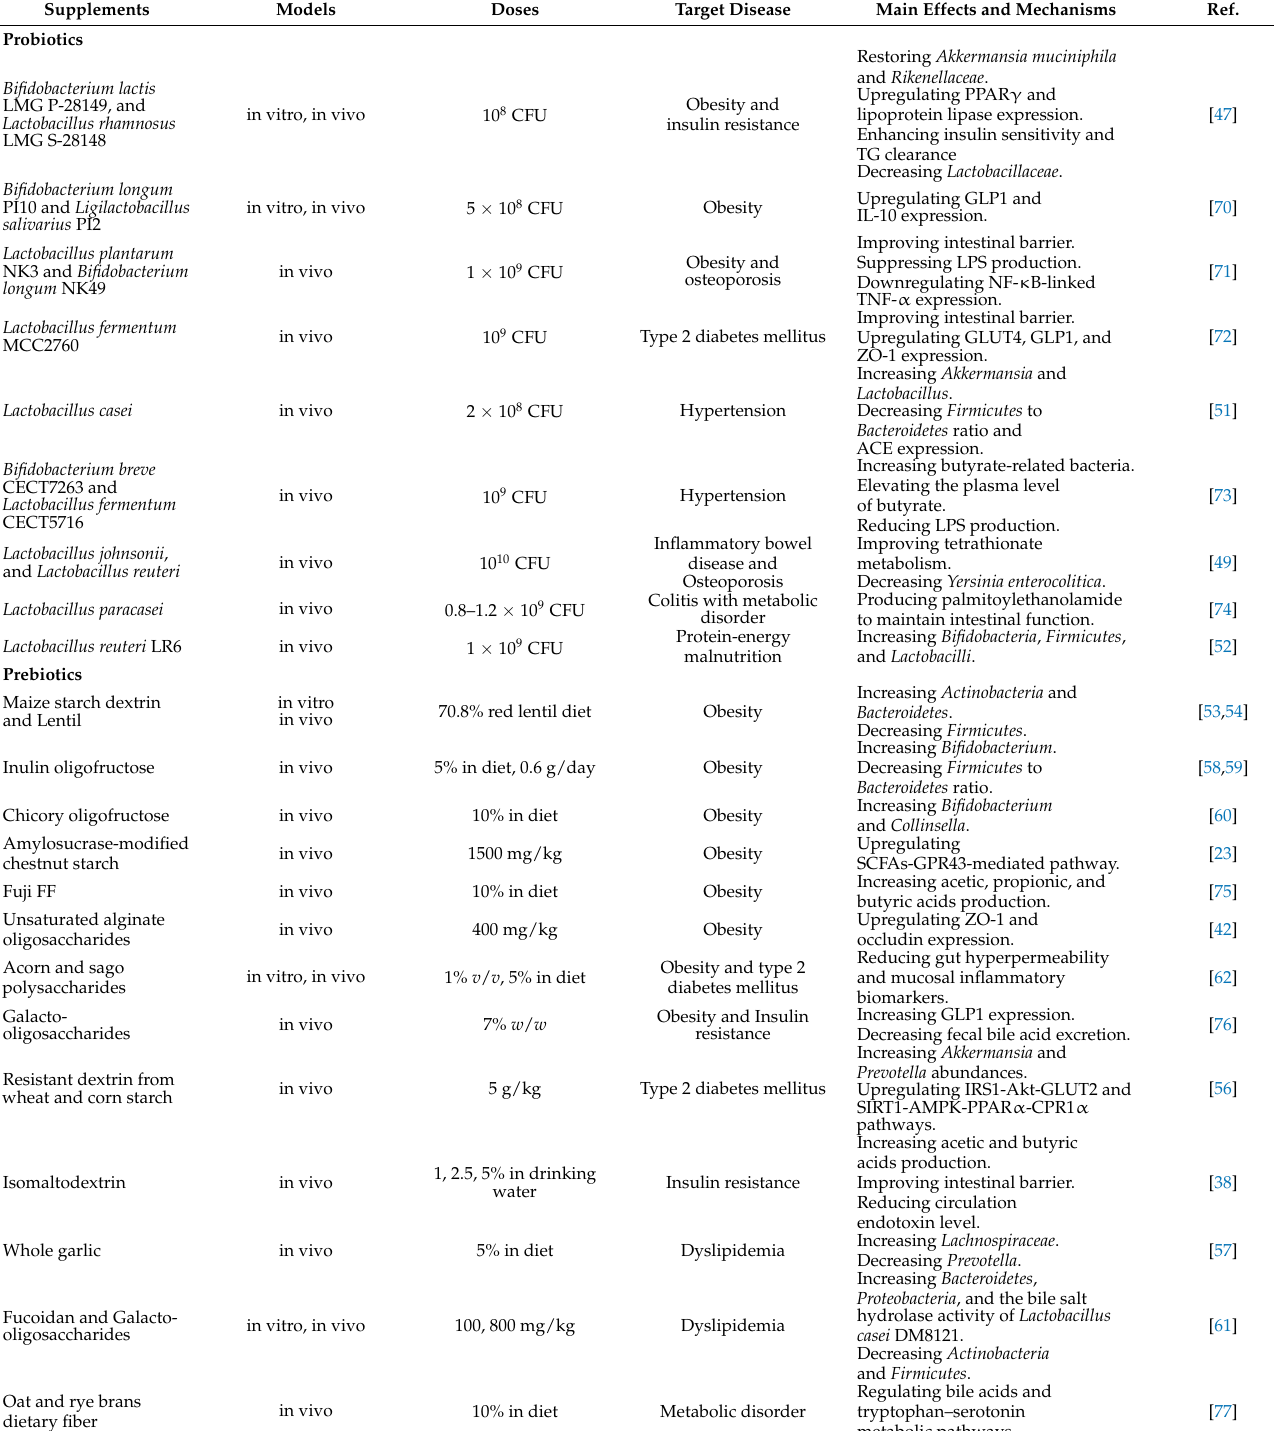
Table 1. The effects and mechanisms of probiotics, prebiotics, synbiotics, and postbiotics on metabolic diseases from experimental